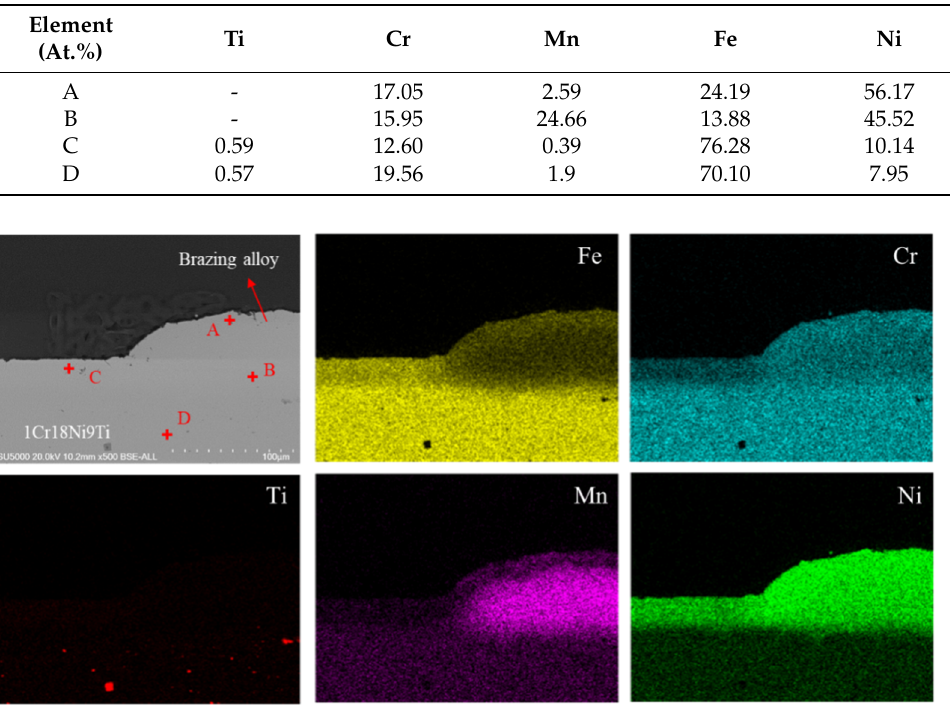
Figure 8. The SEM image and the corresponding element map distribution of brazing alloy on substrates of acid treatment + 4 μm Ni at 1170 °C/25 min. Table 4. The EDS results in Figure 8.